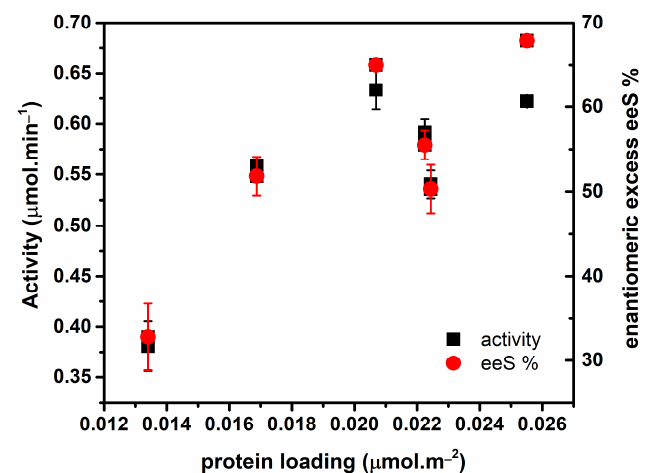
Figure 8. Biocatalytic activity (expressed as the micromoles of converted rac -ibuprofen per min) and the enantiomeric excess toward S-ibuprofen (eeS%) as a function of protein loading of immo- bilized lipase on Ns SiO 2 . The esterification of rac -ibuprofen with ethanol was carried at 45 °C for 24